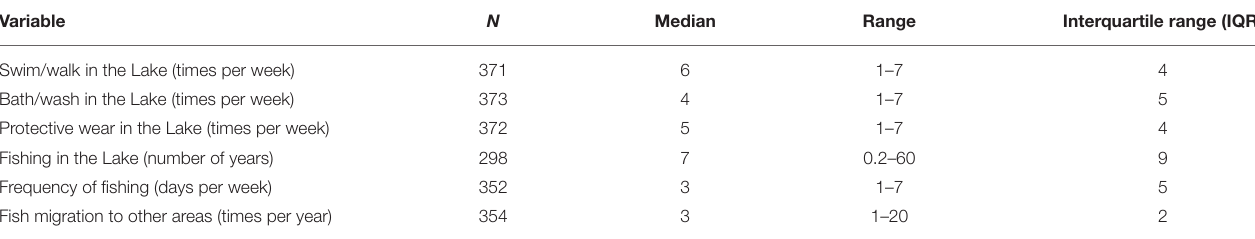
TABLE 9 | Proportion of participants who reported on their water contact and fishing history in the Lake in the preceding months before the study.